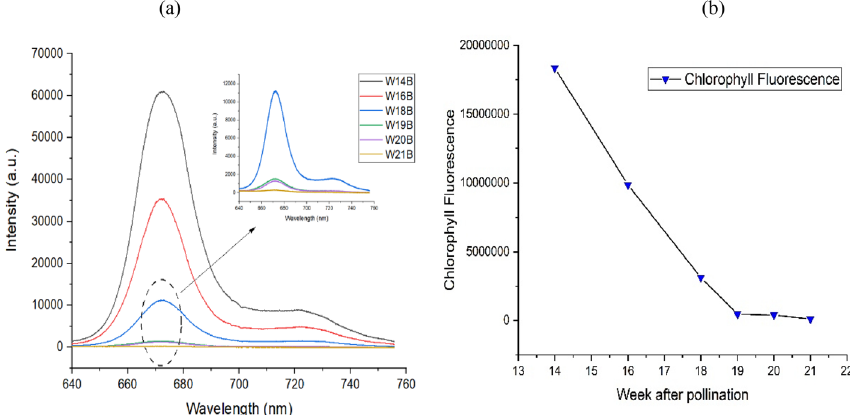
Figure 4. ( a ) LICF chlorophyll fluorescence spectra of CPO of FFB from different weeks after pollination. ( b ) Fluorescence area plot vs weeks after